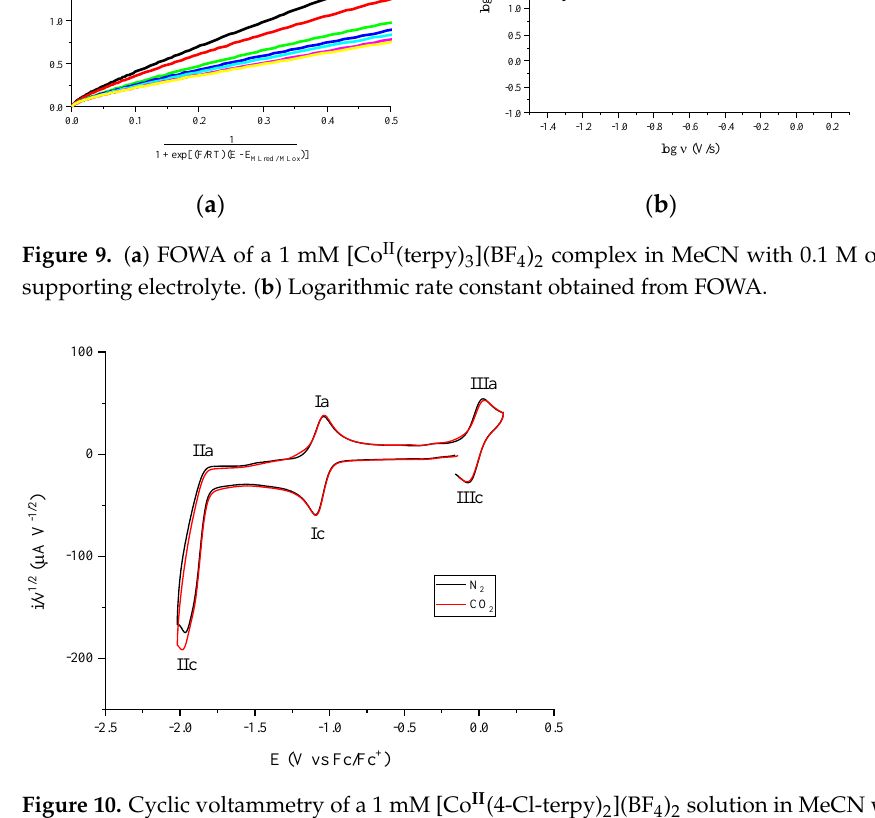
Figure 10. Cyclic voltammetry of a 1 mM [Co II (4-Cl-terpy) 2 ](BF 4 ) 2 solution in MeCN with 0.1 M of TBAPF 6 , bubbled with N 2 (black line) and CO 2 (red line). Scan rate of 100 mVs −1 obtained from open-circuit potential to cathodic direction. Glassy carbon disk as a working electrode.